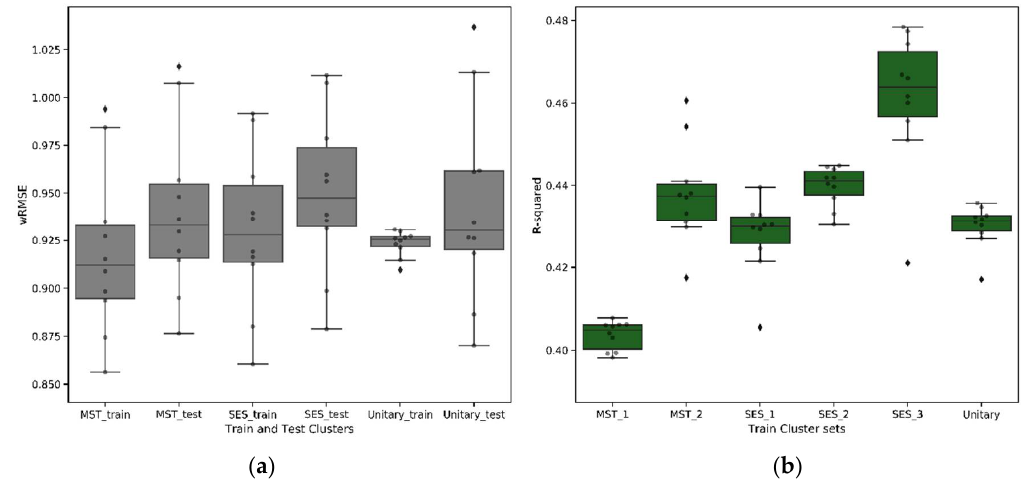
Figure 10. Evaluation metric: ( a ) weighted root mean square error (wRMSE) from each k-fold model (train and test), averaged across a cluster; ( b ) R-squared on train models on each cluster set.